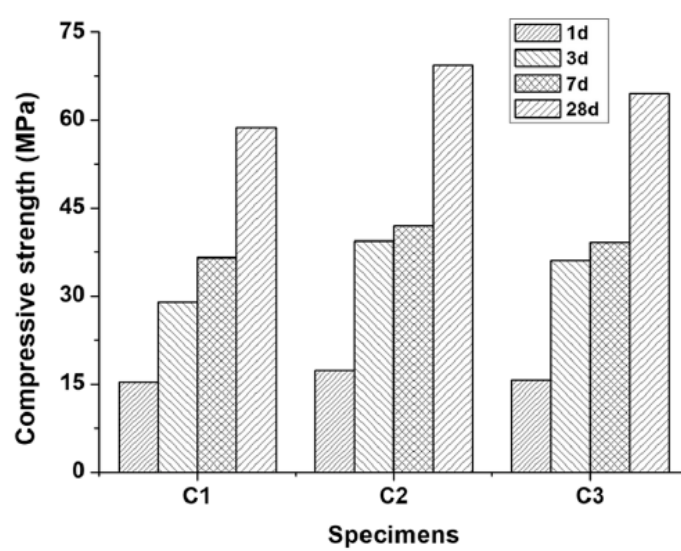
Figure 18. Compressive strength of the pastes: C1, reference paste; C2, paste containing nano-Fe 3 O 4 in magnetic fluid form; and C3, paste containing nano-Fe 3 O 4 in powder form (Reprinted with permission from [94]. Copyright 2018 Elsevier).